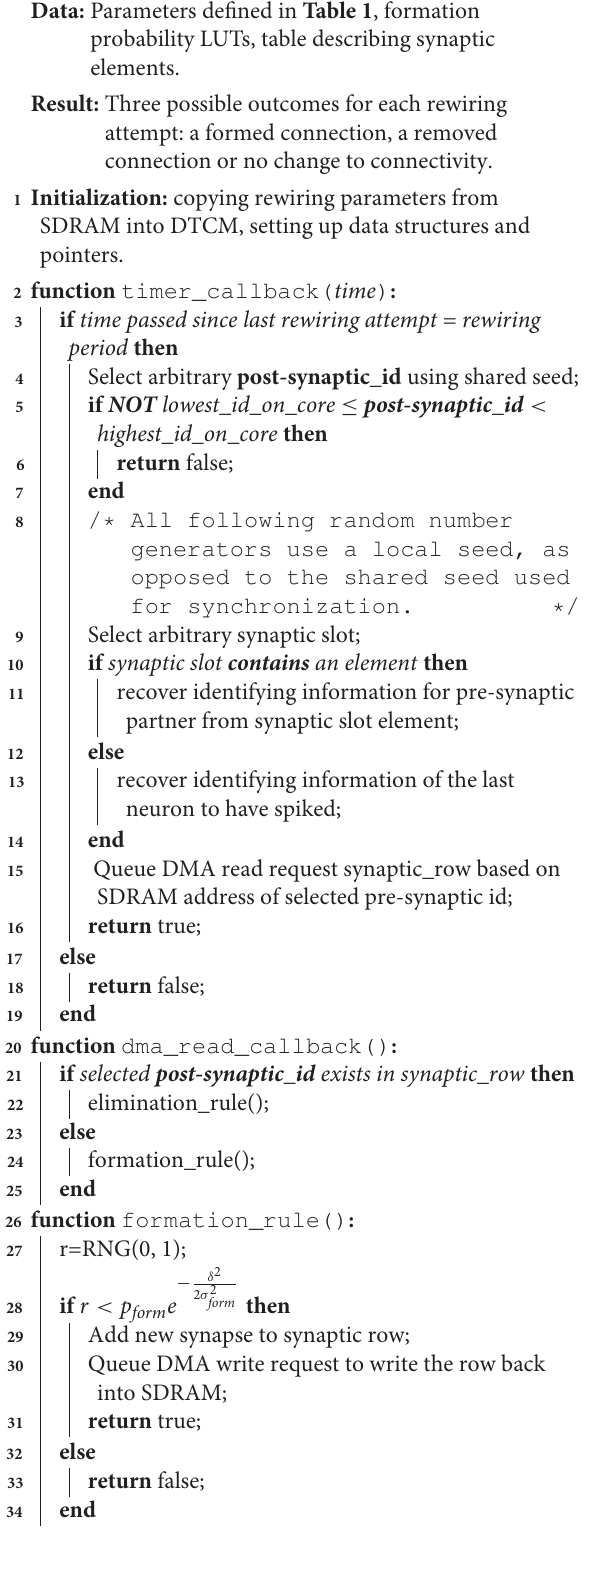
Algorithm 1: Algorithmic description of the synaptic rewiring model running on SpiNNaker. Data: Parameters defined in Table 1 , formation probability LUTs, table describing